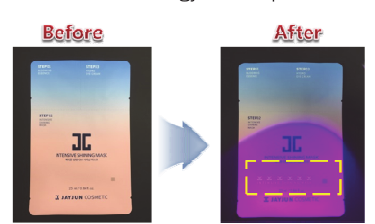
<Figure 11> Various Examples of Mask Pack with New Technology Development